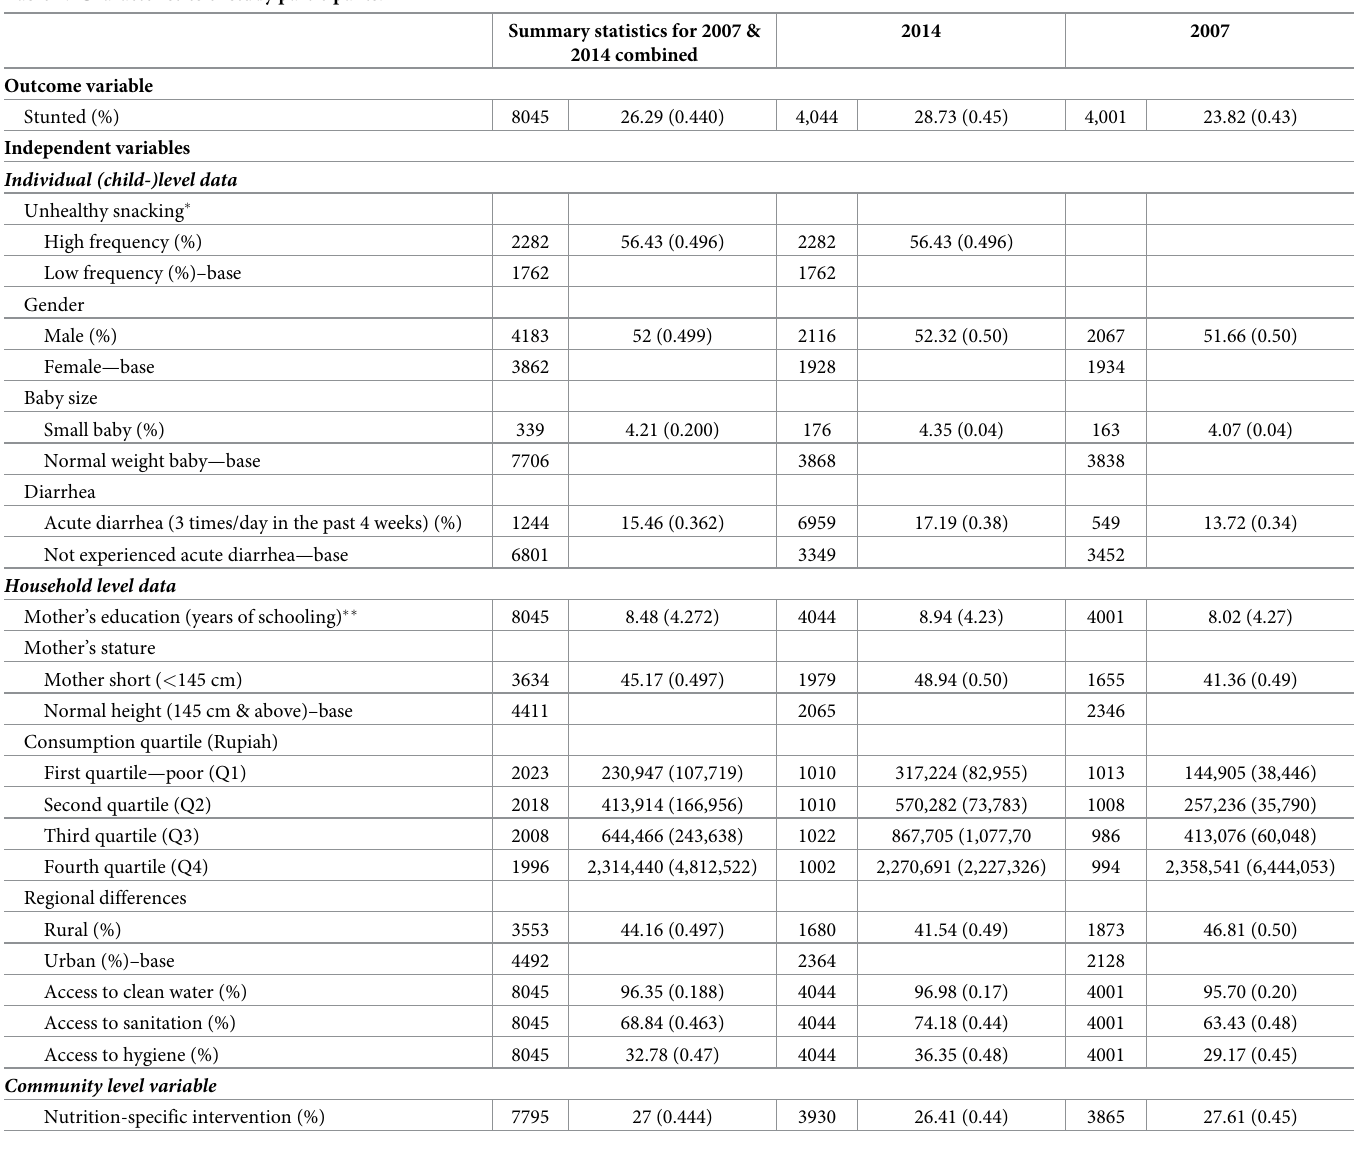
Table 1. Characteristics of study